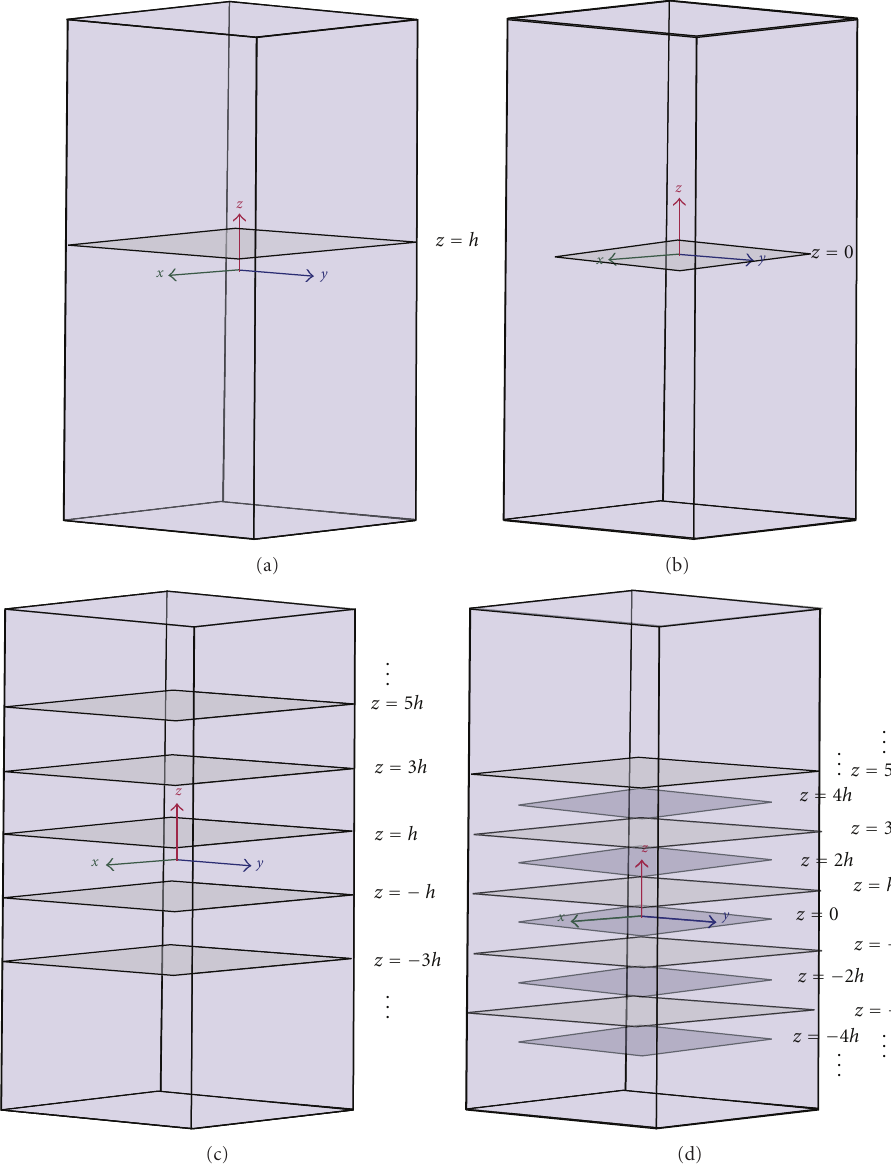
Figure 3: Equivalent “waveguides” with Bloch periodic boundaries at four sides, opened at two ends; (a) excited by equivalent magnetic currents at z = h ; (b) excited by equivalent magnetic currents at z = 0; (c) excited by equivalent magnetic currents and their images at z = (2 p + 1) h , p = ... , − 1,0,1, ... ; (d) excited by equivalent magnetic currents and their images at z = (2 p + 1) h and z = (2 p ) h , where p = ... , − 1,0,1, ...